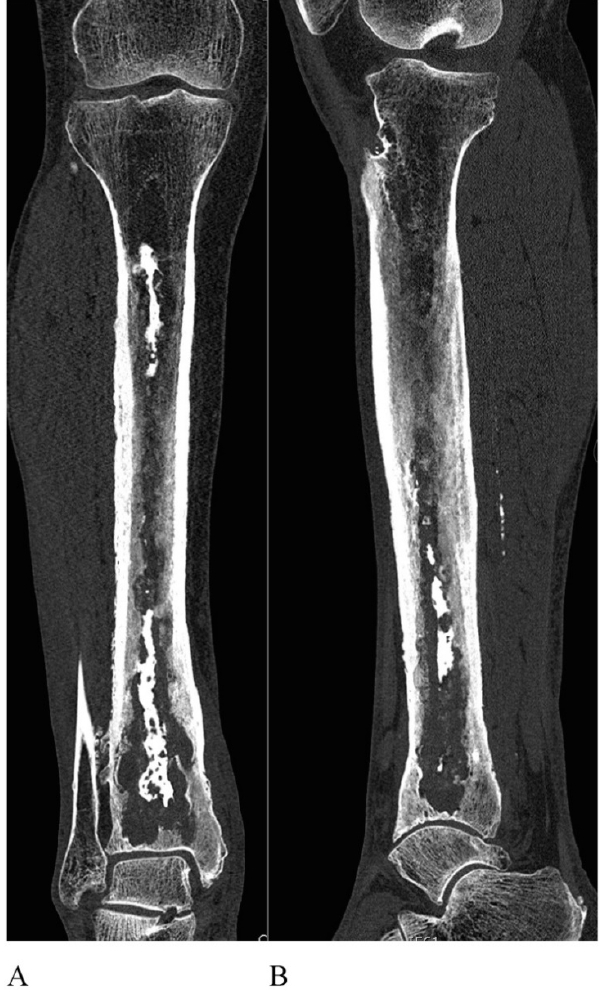
Figure 3. Visible sequestrae along the whole medullary canal.